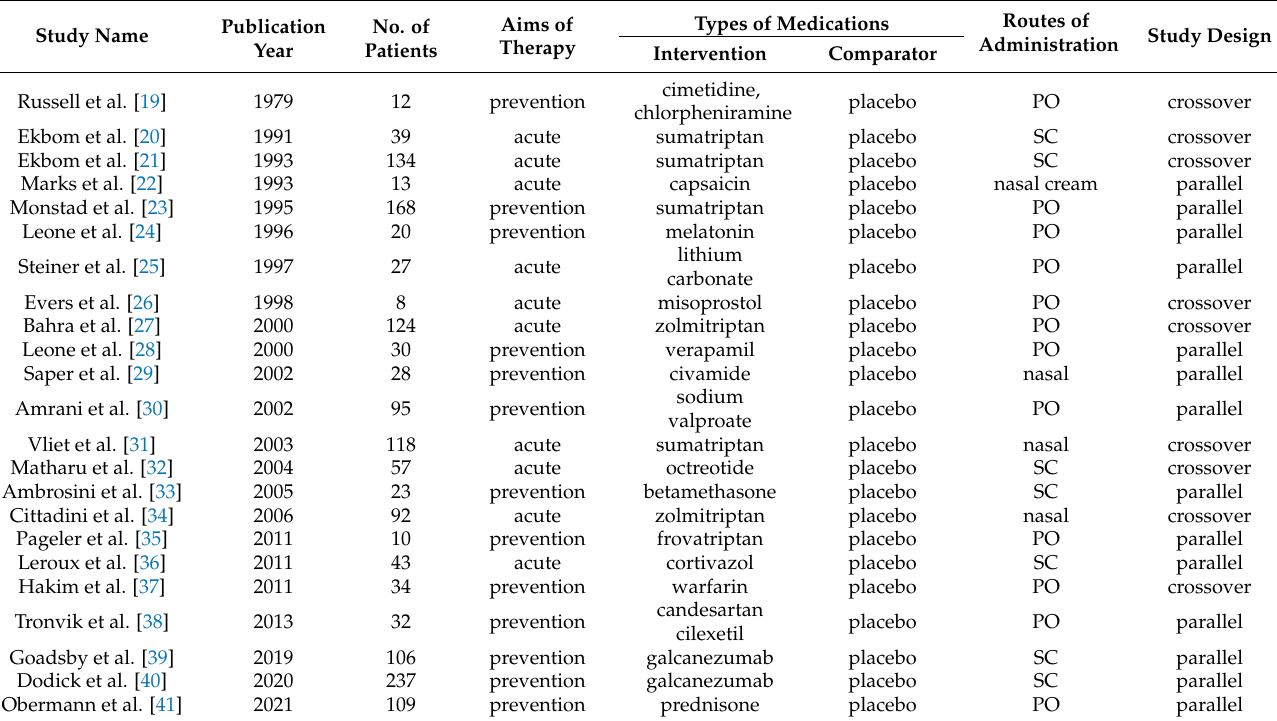
Table 1. Characteristics of the included